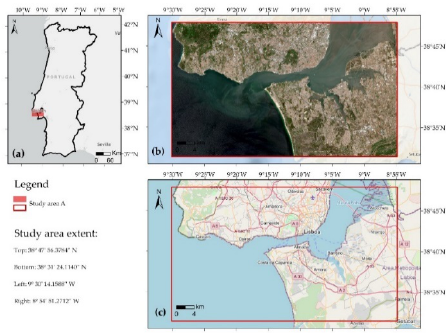
Figure 1. Study area A: ( a ) Location within continental Portugal, ( b ) Sentinel-2 satellite image of the study area collected in 19 June 2018, ( c ) OSM data available in the study area (OSM basemap provided by ESRI).